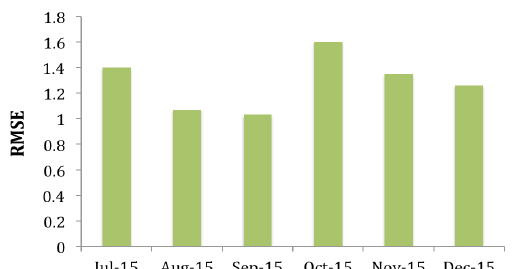
Figure 6. Root-mean-square error between forecasted and observed